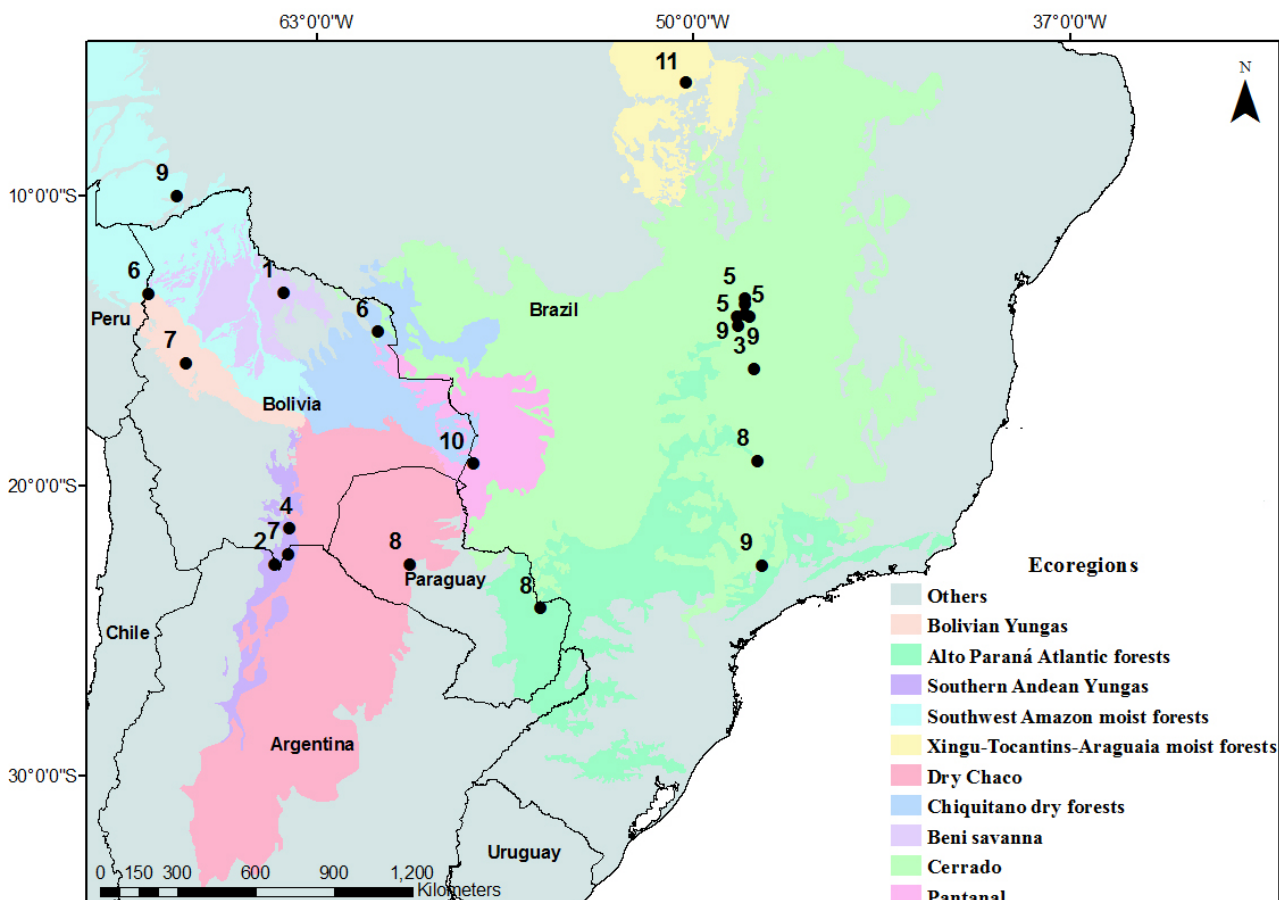
Figure 1. Known localities for